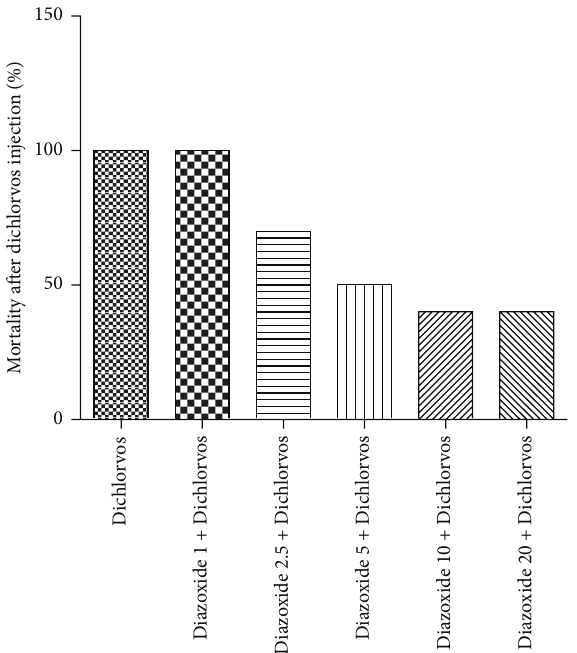
Figure 3: Effect of different doses of Diazoxide (mg/kg) on the mortality percentage after injection of Dichlorvos (50 mg/kg) ( 𝑛 = 10 ).